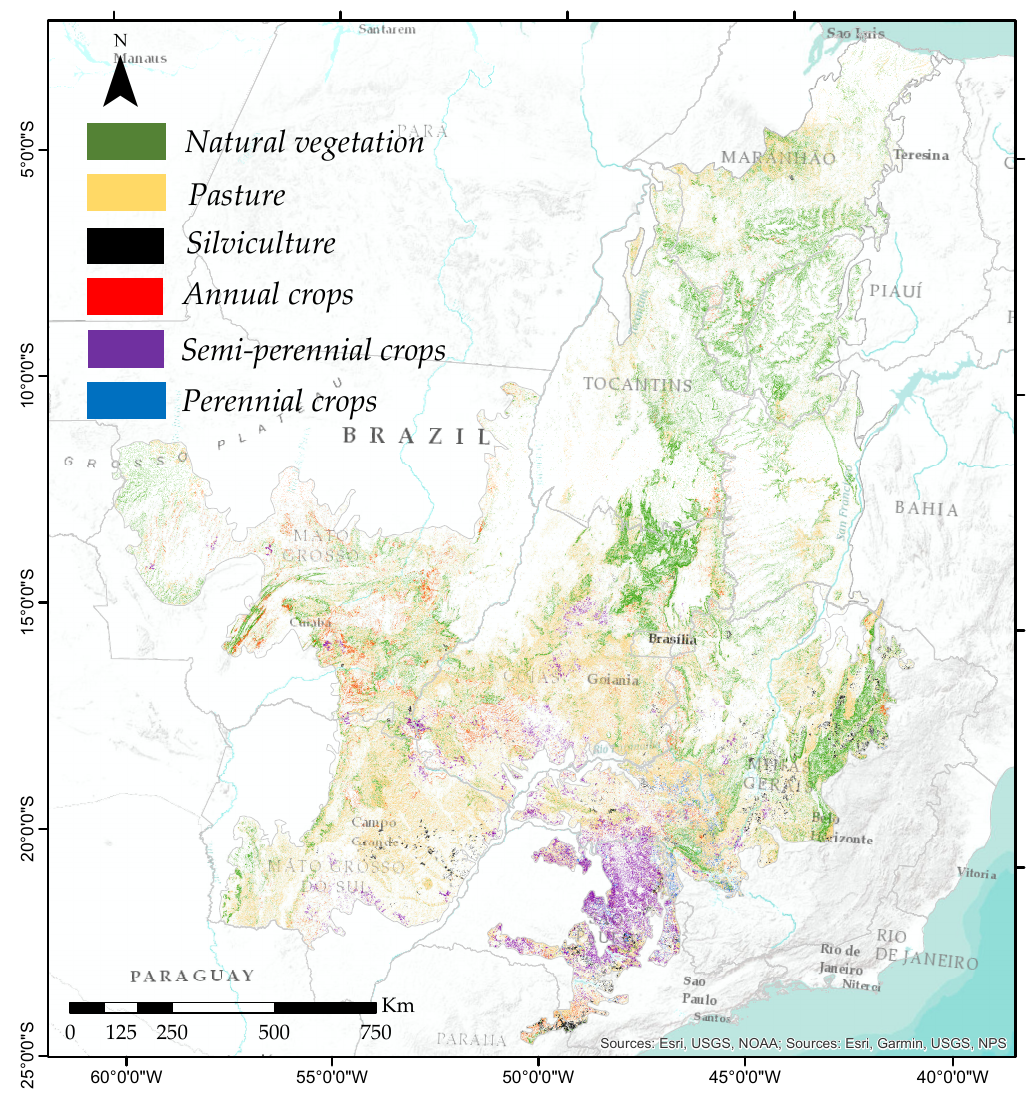
Figure 5. Severely eroded (>11 t ha − 1 yr − 1 ) areas in the Brazilian Cerrado (reference year: